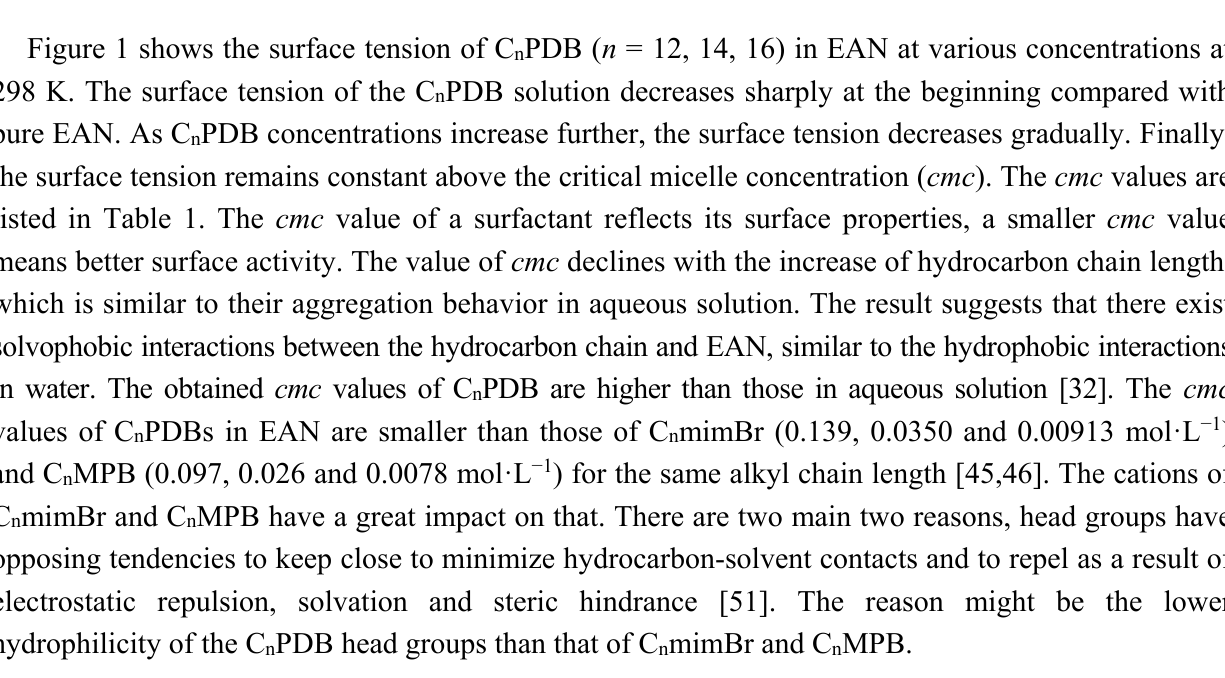
Figure 1. Surface tension as a function of C n PDB concentration at 298.15 K.